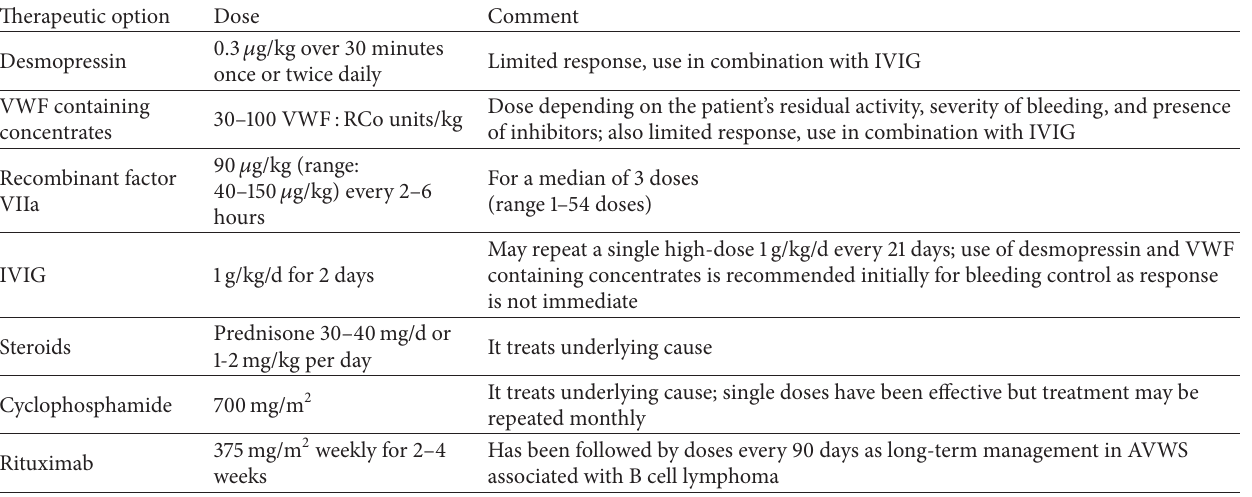
Table 3: Therapeutic options in acquired von Willebrand syndrome associated with